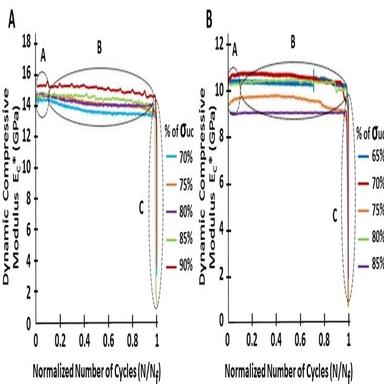
Conventional fatigue testing results for dynamic compressive modulus E\. (A) Type A configuration, (B) Type B configuration. N = number of cycles. Nf = number of cycles at failure. Regions A, B, and C, respectively, displayed the initial, steady state, and failure conditions.